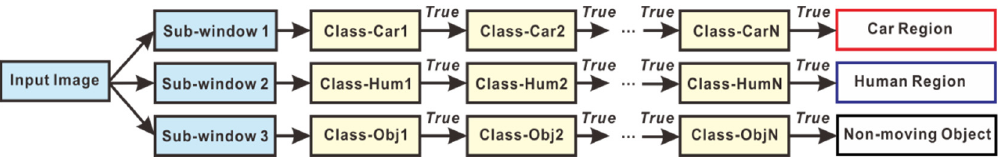
Figure 5. Cascade classifier for object detection and recognition.